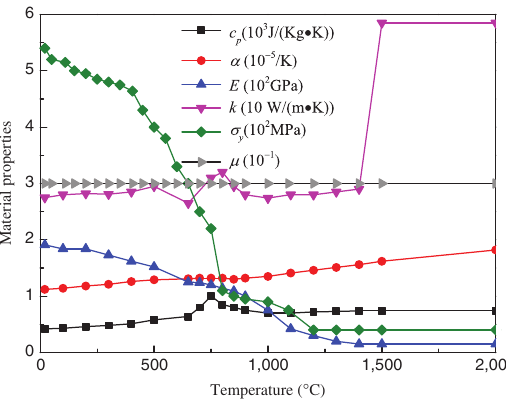
Figure 2: Material properties for P92